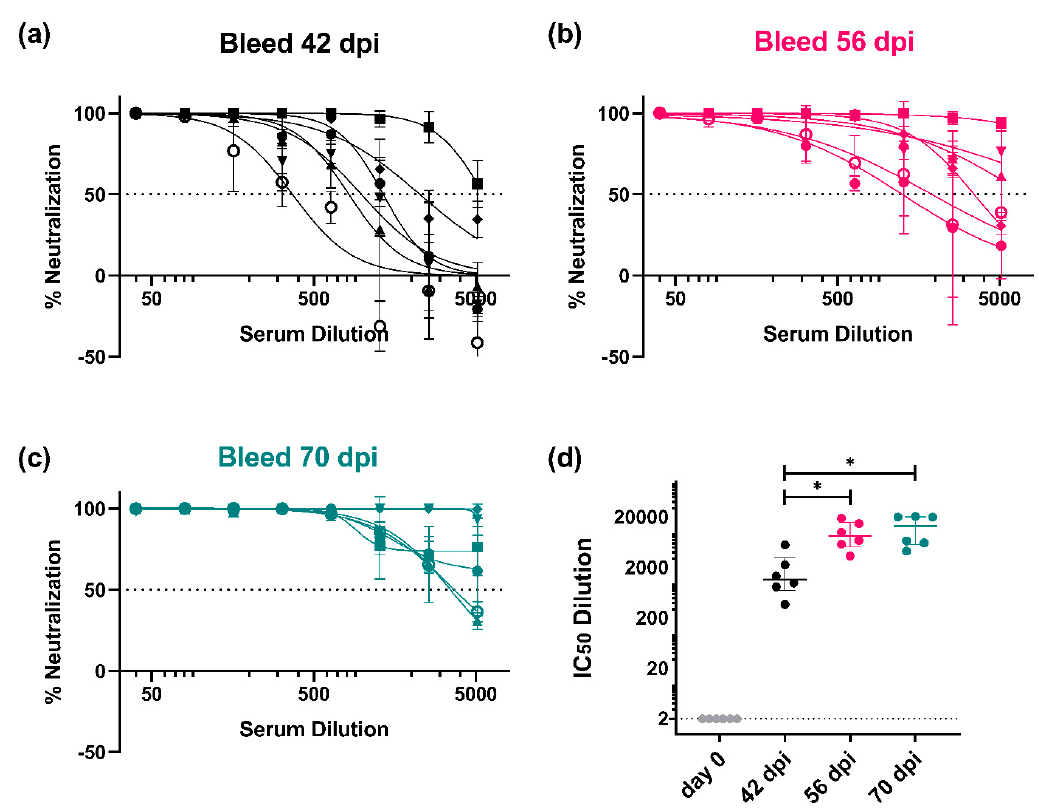
Figure 6. In vitro neutralizing activity of mouse sera against A/England/195/09 (H1) (EN/09) as monitored at specific timepoints during the immunization protocol. Mice were vaccinated with 50 µ g of pEVAC EN/09 (H1) on days 0, 14, 28, and 42 (Figure 1). Bleeds were taken ( a ) 42 days post immunization (dpi), ( b ) 56 dpi, and ( c ) 70 dpi (terminal bleed). Neutralizing activity was tested against 1 × 10 6 RLU of A/England/195/09 (H1) PV. ( d ) Comparison of the half maximal inhibitory dilutions (IC 50 ) in post-vaccination samples as a function of time is shown in brackets (* p < 0.05). The broken line shows an assigned baseline level of 2 indicating 0% neutralization. For plots ( a – c ), the mean and standard deviation of individual mouse serum samples are shown ( n = 6). Plot ( d ) shows the median and interquartile range of samples tested.